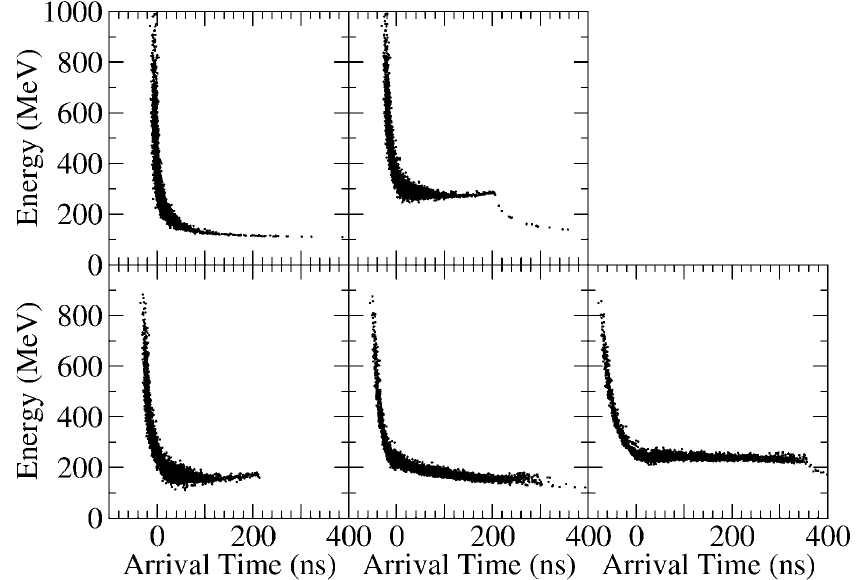
FIG. 16. Evolution of the beam distribution in the phase rotation section. The graphs show the distribution before the phase rotation, after the first induction linac (top row, left to right), after minicooling, and after the second and third induction linacs (bottom